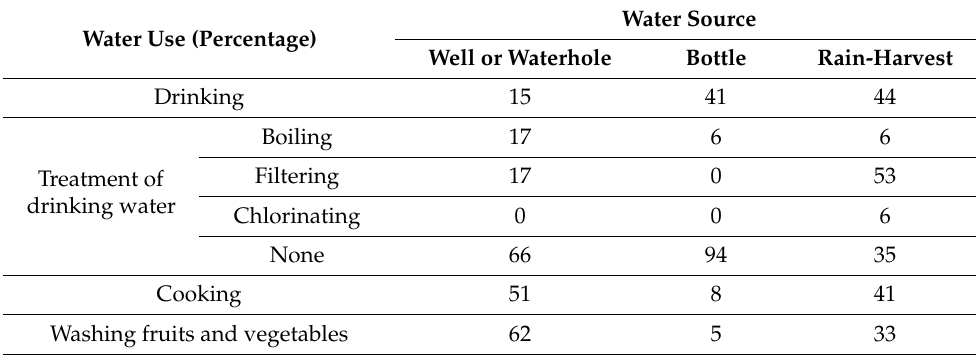
Table 2. Sources of water for different uses, their treatment, and fluoride concentrations in the High Basin of the Laja River, 2018.